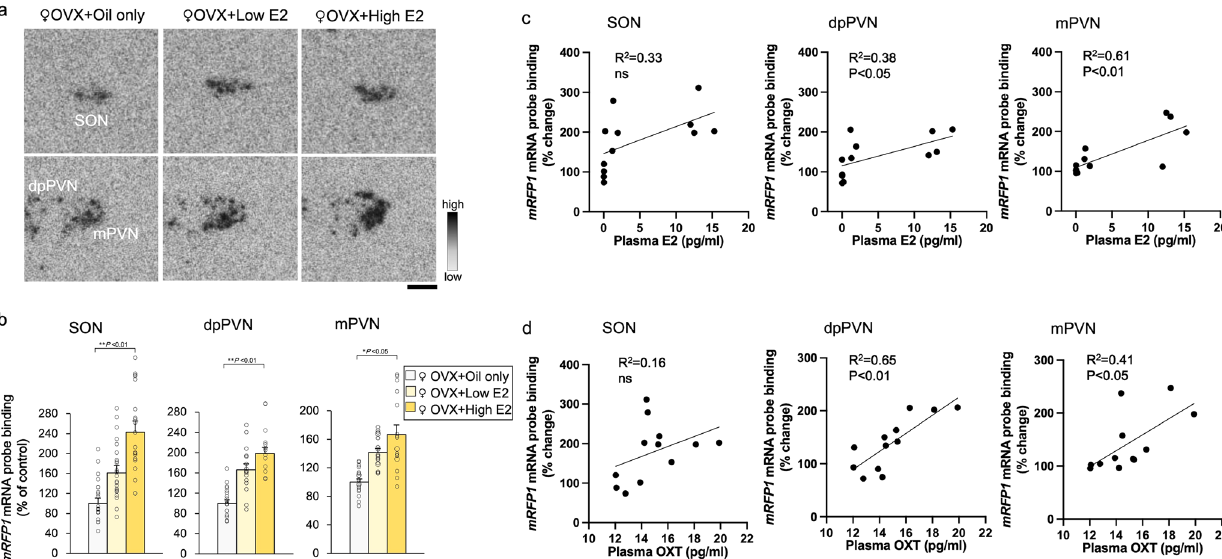
Fig. 6 Effects of oestrogen replacement on mRFP1gene expression. a Representative images hybridised with a 35S-labelled oligodeoxynucleotide probe complementary to mRFP1 in the SON, dpPVN, and mPVN of female OXT-mRFP1 transgenic rats in the OVX + oil-only ( n = 6), OVX + low E2 ( n = 6), and OVX + high E2 ( n = 6) groups, respectively. The scale bar indicates 100 μ m. b mRFP1 mRNA in the SON, dpPVN, and mPVN of the rats (OVX + oil-only, OVX + low E2, and OVX + high E2 groups). The data are presented as the mean ± SEM (one-way ANOVA) ( ** P < 0.01, * P < 0.05, compared with OVX + oil only group). c Regression analysis for plasma E2 and changes in mRFP1 mRNA levels in the SON, dpPVN, and mPVN. The regression line and probability value for the slope are shown. The statistical signi fi cance of the slope was set at P < 0.05. d Regression analysis for plasma OXT and changes in mRFP1 mRNA levels in the SON, dpPVN, and mPVN. The regression line and probability value for the slope are shown. The statistical signi fi cance of the slope was set at P <